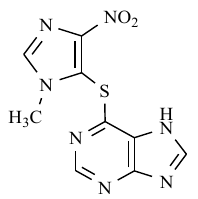
Figure 7. Anti-immunosuppressants: Azathioprine.